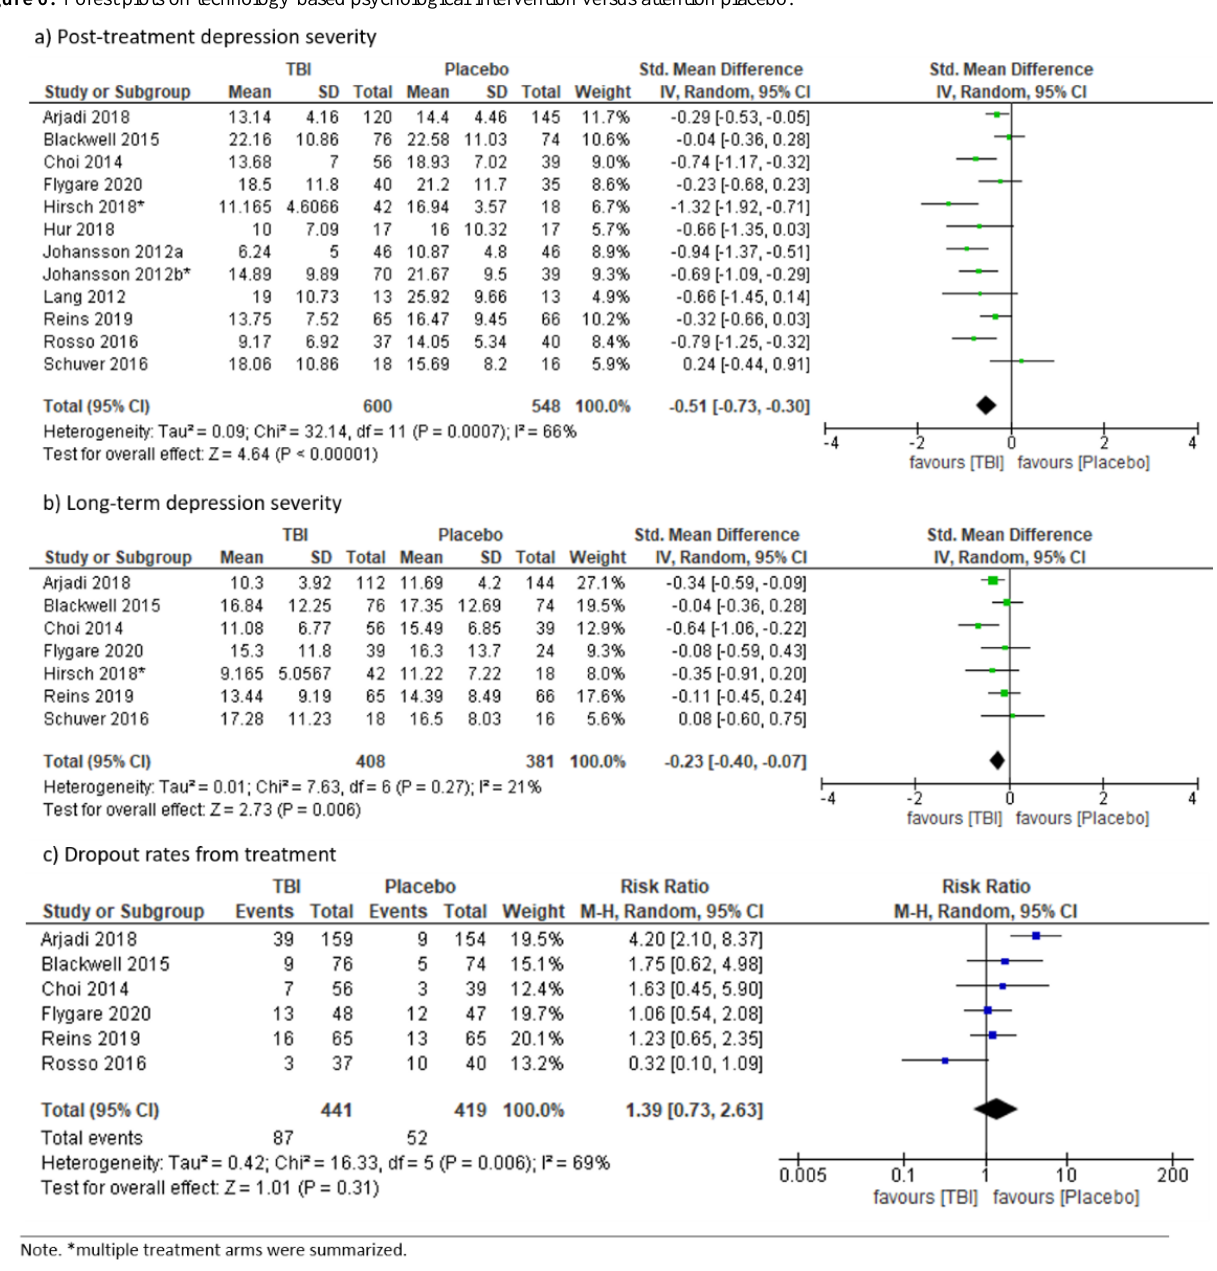
Figure 6. Forest plots on technology-based psychological intervention versus attention